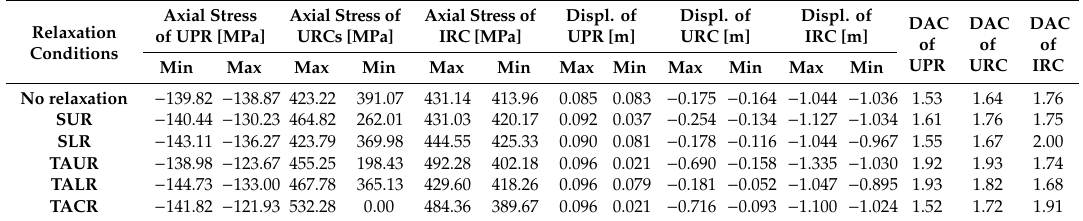
Table 2. Structural dynamic response under di ff erent kinds of cable